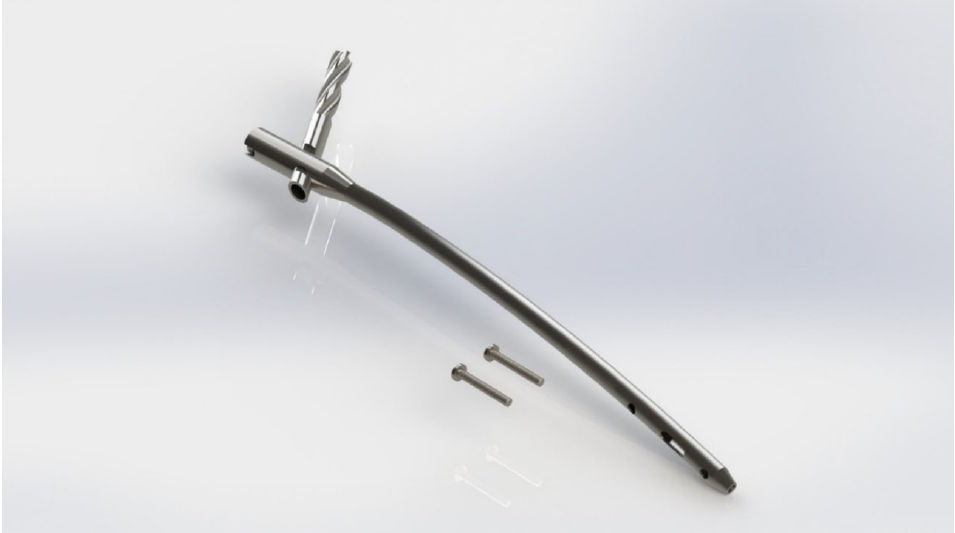
Figure 3. The 3D model of the femoral CM nail, the self ‐ taping helical screw, and two locking screws modeled using SolidWorks.